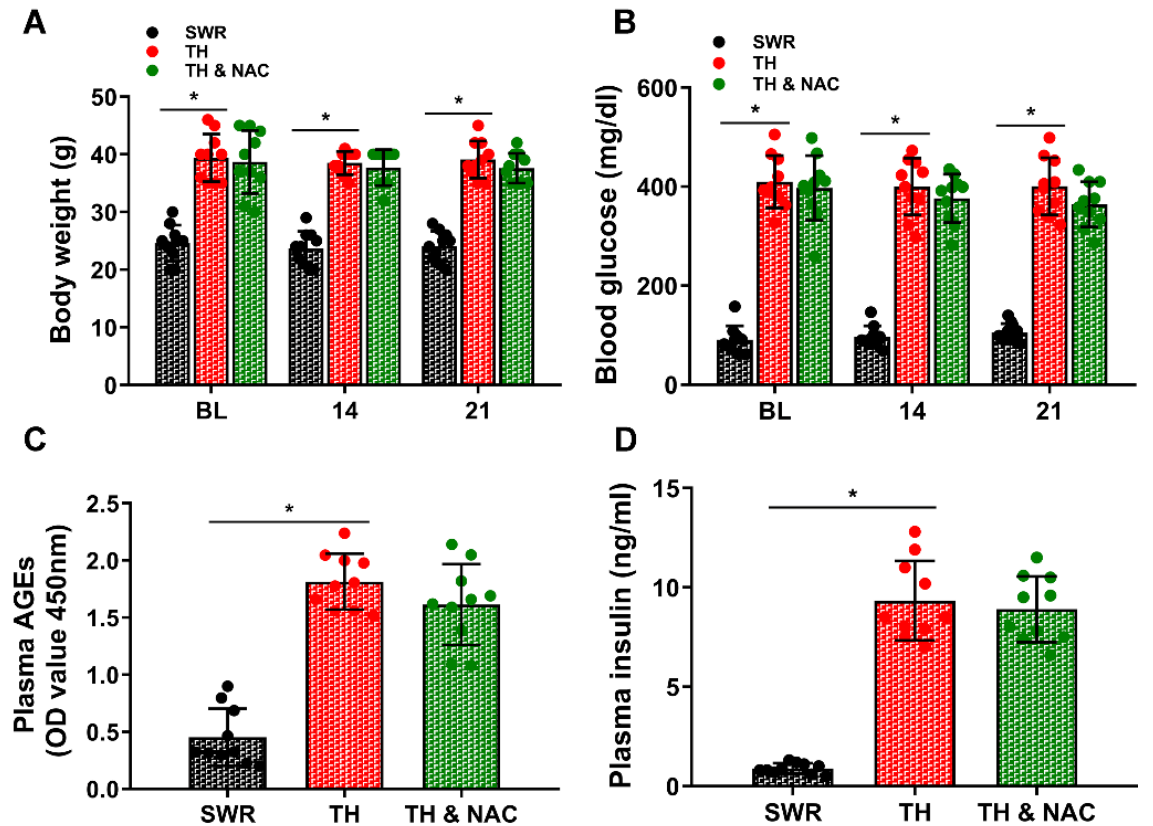
Figure 1. Body weight and the levels of blood glucose, plasma AGEs, and insulin in diabetic and non-diabetic mice. The body weight, blood glucose, and plasma AGEs levels were obtained before creation of limb ischemia in mice. Body weight ( A ), blood glucose ( B ), plasma AGEs ( C ), and insulin ( D ) were all significantly increased in diabetic TALLYHO/JngJ (TH) mice compared to the non-diabetic SWR/J (SWR) mice. No significant changes in the levels of blood glucose, plasma AGEs, and insulin were observed in diabetic TH mice with NAC treatment at day 21. AGEs, advanced glycation end products; BL, before ligation; NAC, N-acetylcysteine; TH, diabetic TALLYHO/JngJ mice with CLI operation; SWR, non-diabetic SWR/J mice with CLI operation; TH & NAC, TALLYHO/JngJ mice with CLI operation plus NAC treatment. All data are shown as means ± SD. * p < 0.01; n = 10/group. Statistical differences were determined by two-way repeated measures ANOVA followed by Tukey’s post hoc test ( A , B ) and one-way ANOVA with Tukey’s test ( C , D ).